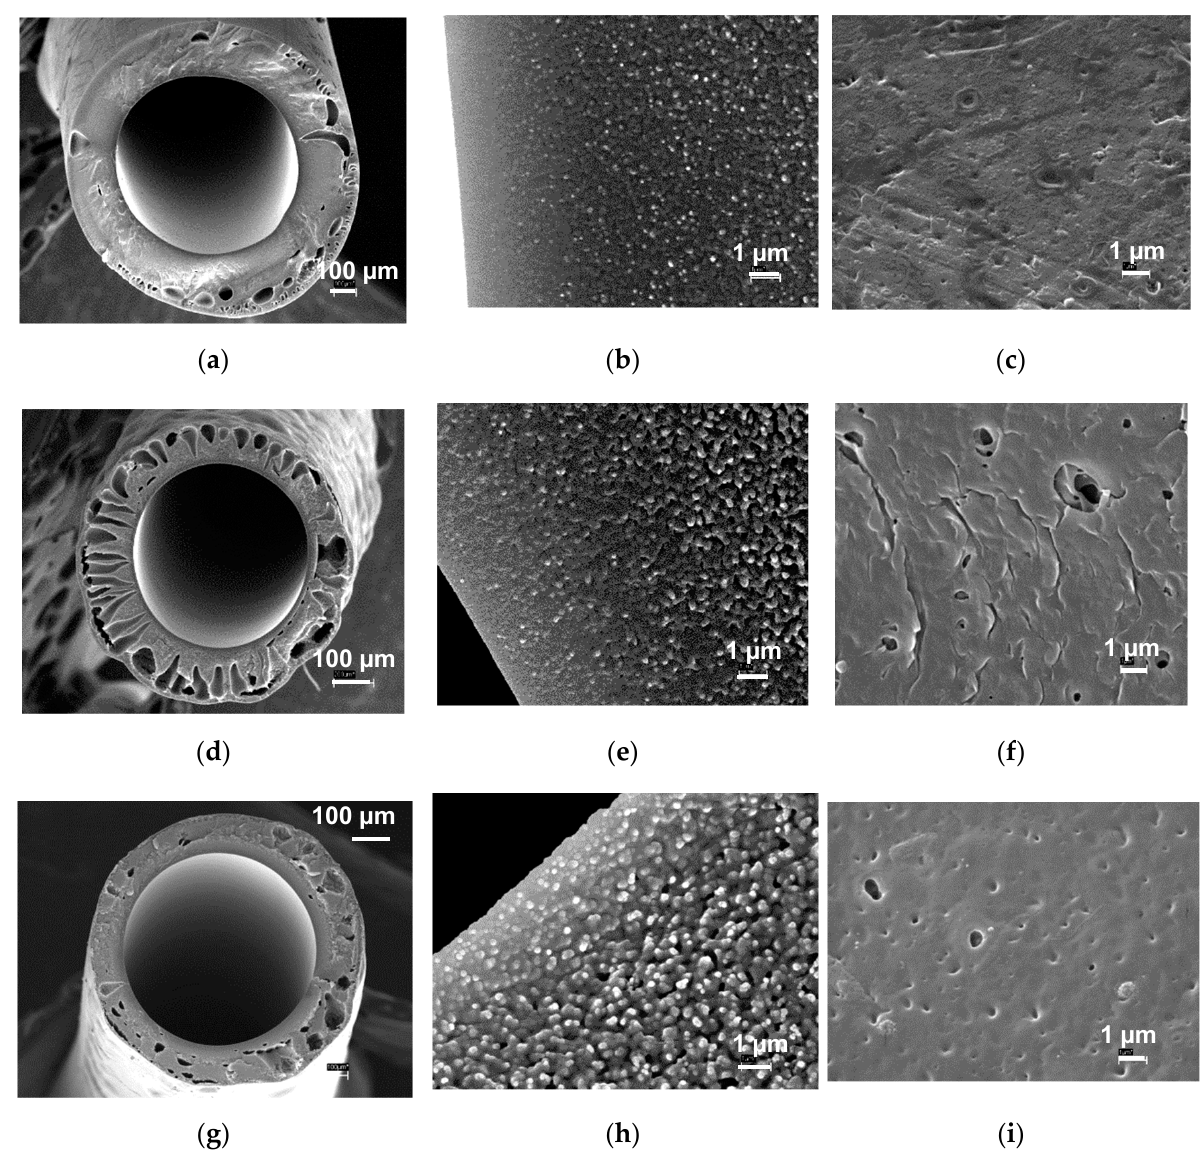
Figure 4. SEM micrographs of the membrane cross-section ( a , d , g ), fragment of the cross-section of the selective layer ( b , e , h ) and outer surface ( c , f , i ), obtained from dope solution A ( a – c ), B ( d – f ) and C ( g – i ) at the bore fluid temperature T = 80–83 °C.